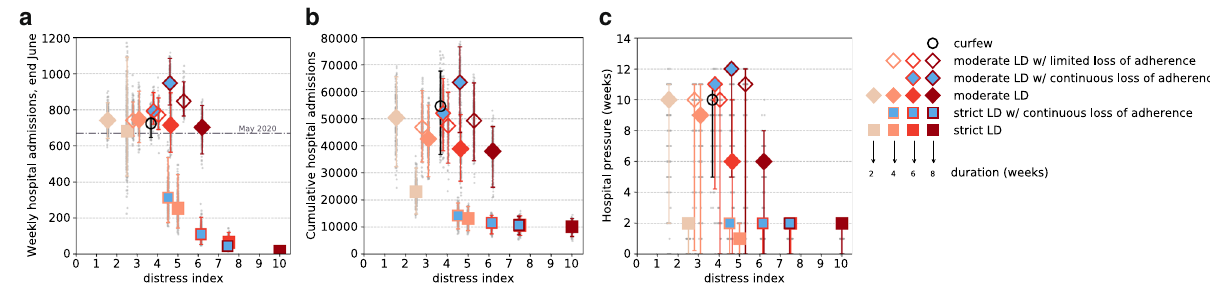
Fig. 4 Intervention ef fi cacy vs. associated policy-induced distress. Weekly hospital admissions at the end of June (w26) ( a ), cumulative hospital admissions (computed in the time period w12 – w26) ( b ), hospital pressure, de fi ned as the number of weeks in which hospital admissions remain above the peak level achieved during the second wave, in the period w12 – w26 ( c ) as functions of the distress index. Results refer to the accelerated vaccination pace of 300,000 fi rst doses/day since April. Symbol types refer to the stringency of intervention (squares representing a strict lockdown scenario, diamonds representing a moderate lockdown scenario, void circle representing the projection under the curfew scenario). Color shades of the symbol contour refer to the duration (weeks) of the lockdown intervention (from the lightest shade corresponding to 2 weeks, to the darkest one corresponding to 8 weeks); the abbreviation LD in the legend stands for lockdown. Adherence to moderate and strict lockdowns is coded with the fi ll color ( fi lled symbols with the color of the scenario correspond to scenarios with full adherence, void symbols represent scenarios with limited loss of adherence, blue fi lled-in symbols correspond to scenarios with continuous loss of adherence). Plots show median values; error bars represent 95% probability ranges obtained from n = 250 independent stochastic runs (gray points). Horizontal dashed line in panel ( a ) refers to the level of mid-May 2020 at the exit of the fi rst